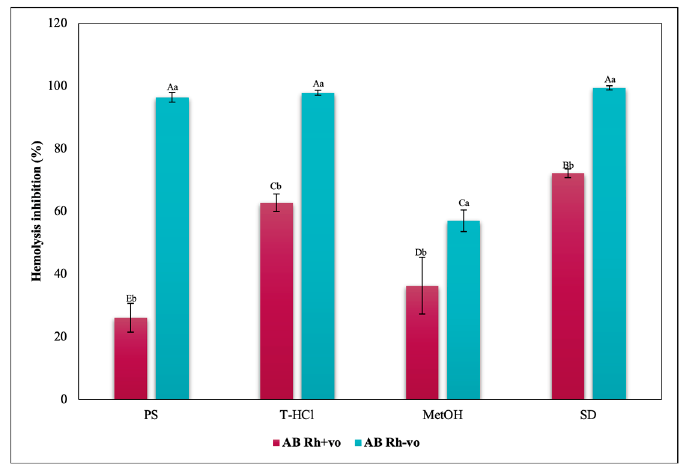
Figure 16. Inhibitory effect of hypotonicity-induced hemolysis of P. cruentum extracts on human erythrocytes with different RhD (positive and negative) of AB blood group. Different letters represent significant differences in the means between treatments and groups ( p ≤ 0.001). Capital letters represent a two-way ANOVA. Lowercase letters represent a univariate ANOVA between the extracts. PS, extract of physiological solution; T-HCl, 0.5 M Tris-HCl extract; MetOH, 99% methanol extract; SD, sodium diclofenac.